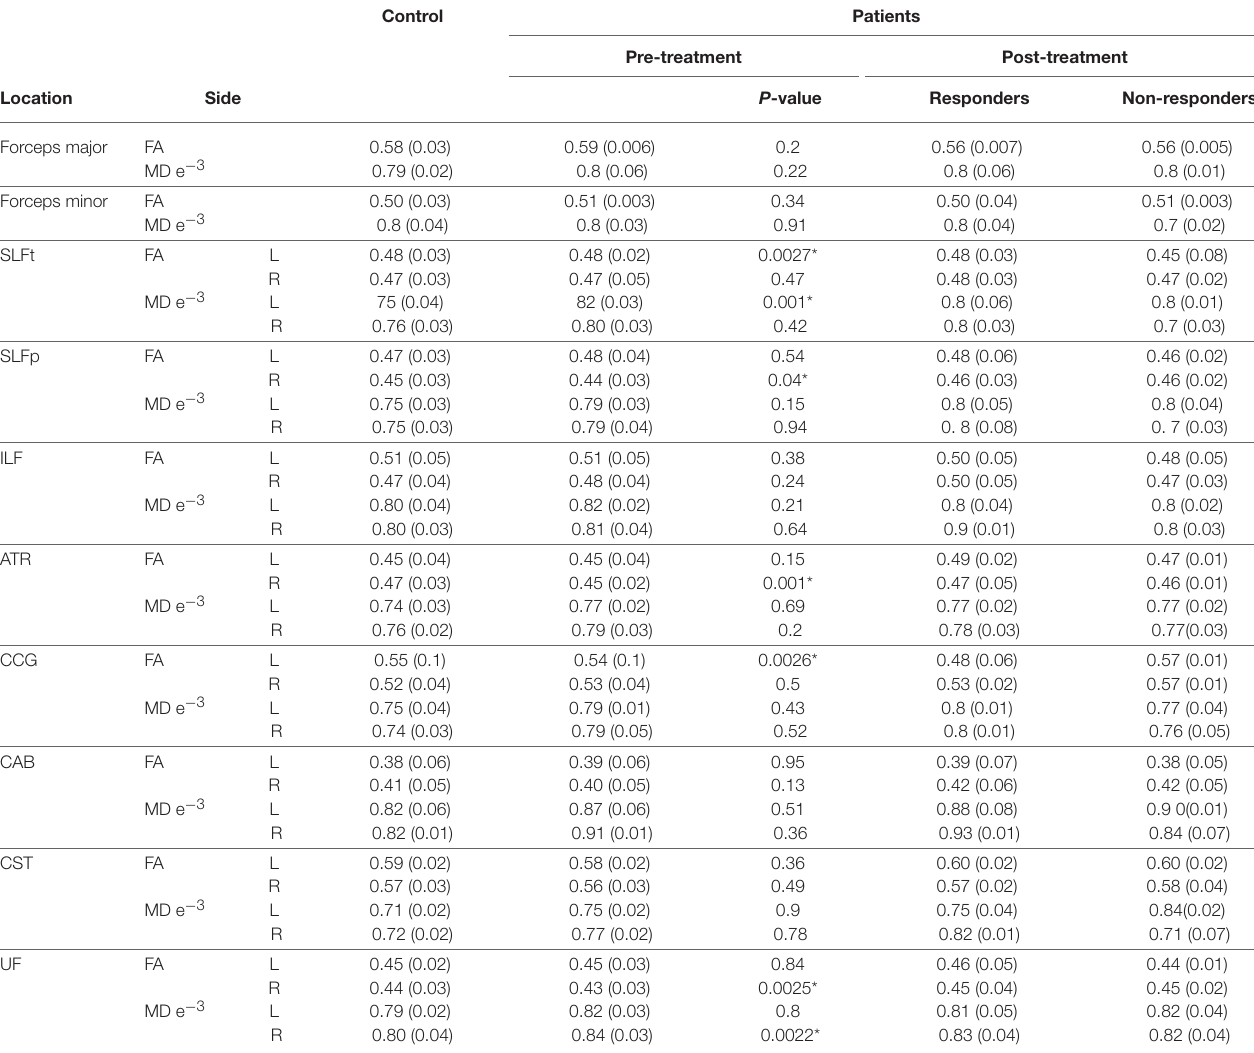
TABLE 5 | FA and MD values [Mean (SD)] in controls; Patients pre-, post- [responders ( n = 8), and non-responders ( n = 4)] 6 months bumetanide